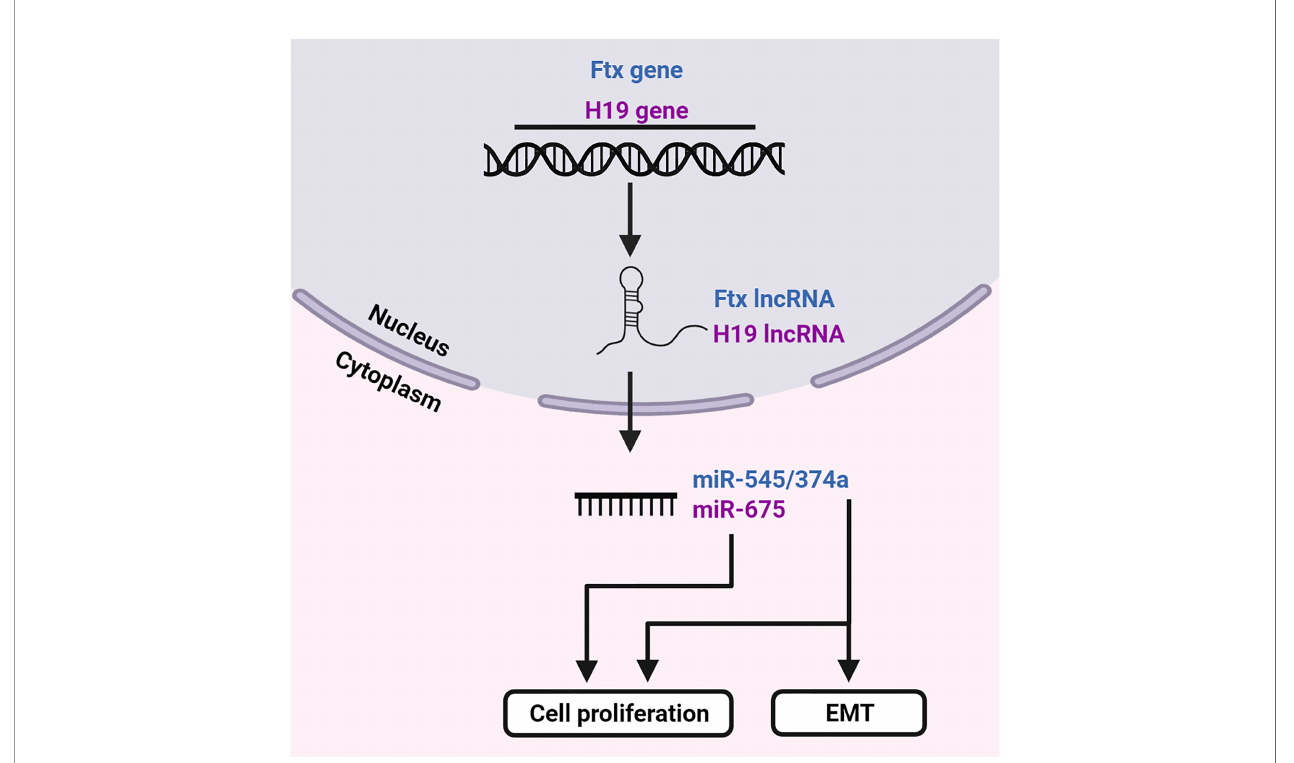
FIGURE 6 | LncRNAs are precursors of miRNAs. The Ftx and H19 genes transcribe lncRNAs Ftx and H19, respectively. LncRNA Ftx encodes the miR-545/374a cluster, which subsequently promotes EMT and cell proliferation. LncRNA H19 transcribes miR-675 which enhances cell proliferation. Created with